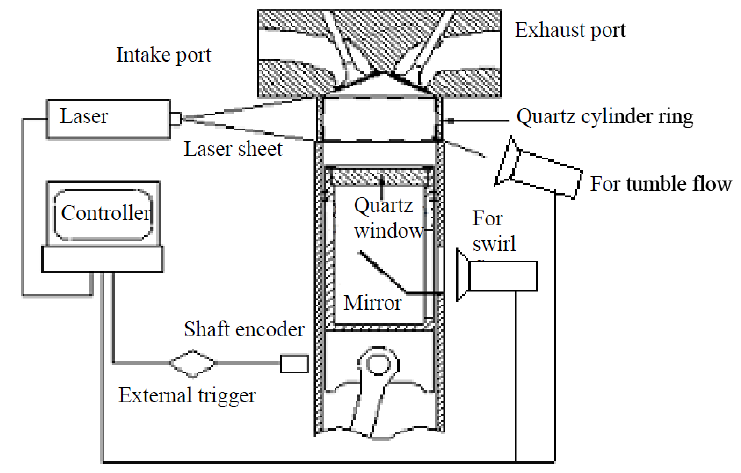
Figure 2. Optical engine set-up and particle image velocimetry (PIV) system for swirl flow and tumble flow measurements.